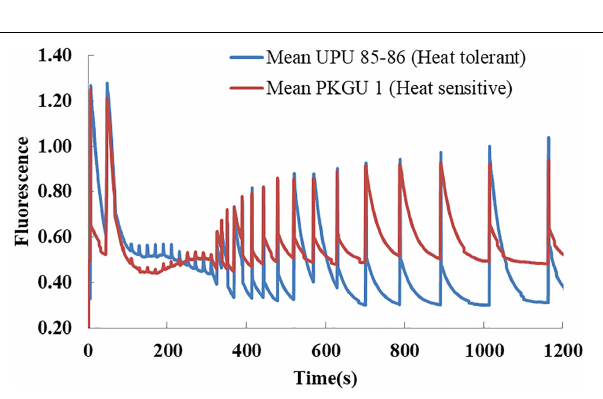
FIGURE 5 | Relative auto-recovery of altered fluorescence during light to dark transition in two contrasting urdbean genotypes (heat-tolerant UPU85-86 and heat-sensitive